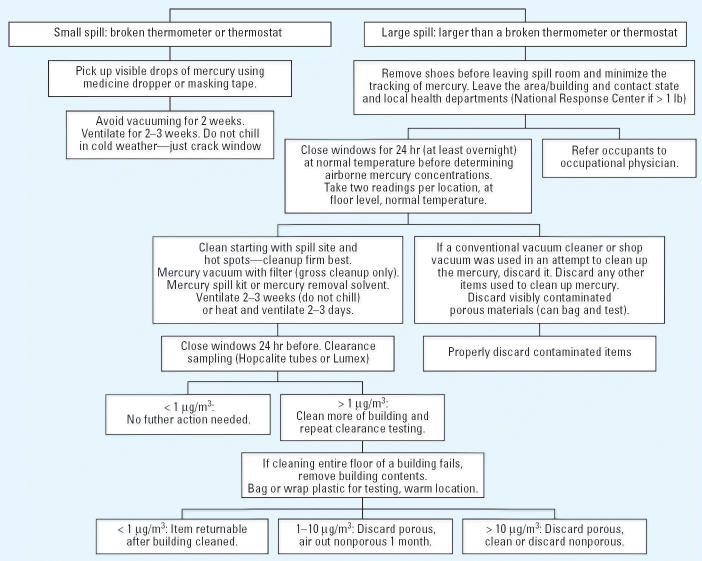
Handling Hg0 spills.